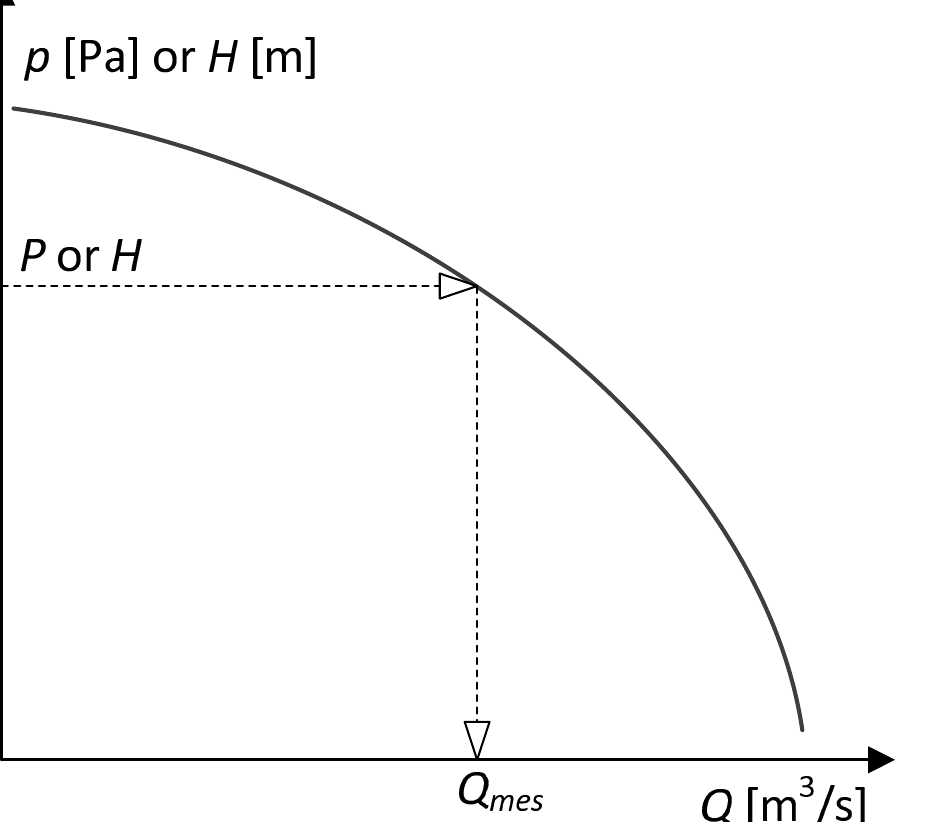
Figure 2. Indirect determination of flow Q est at the measuring point based on the curve, which relates total head H t and flow Q